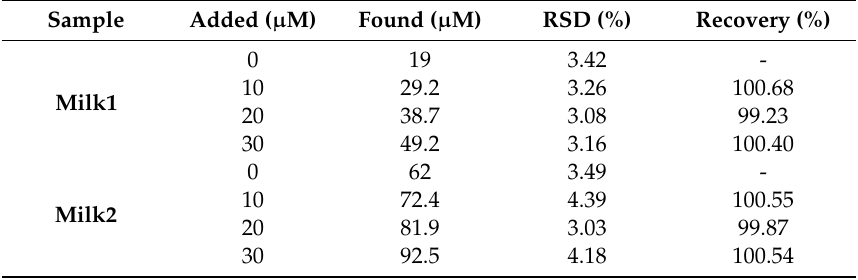
Table 2. Determination and recovery results of streptomycin in two di ff erent milk